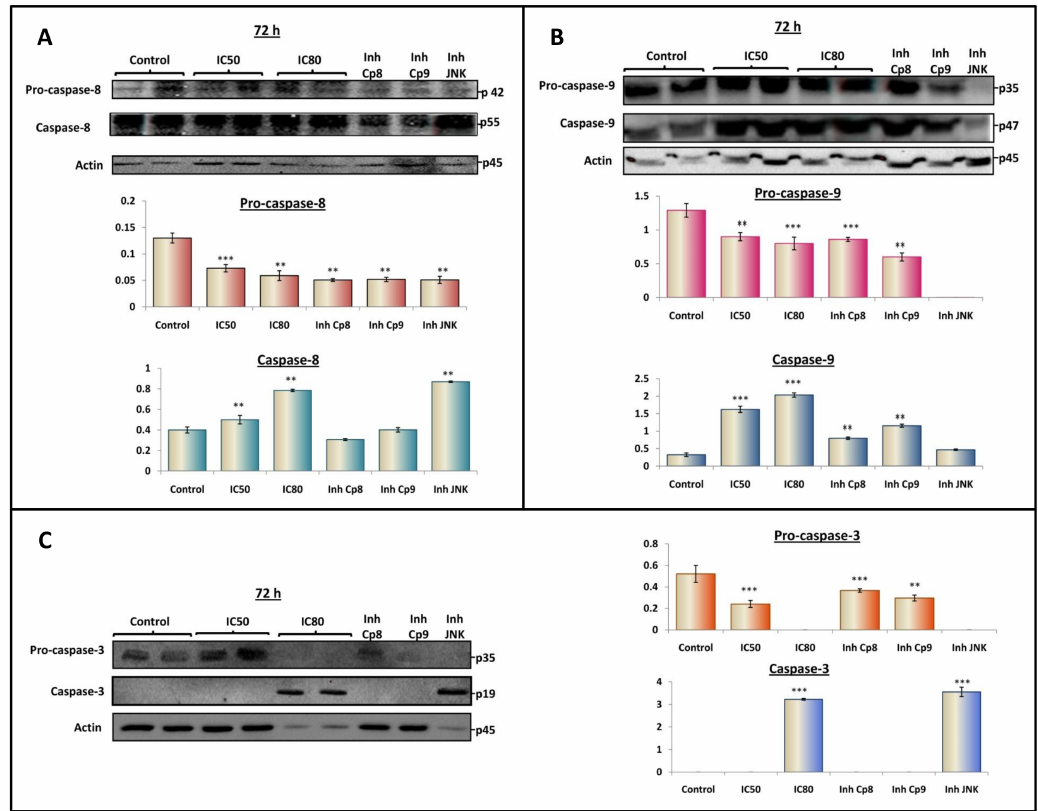
Figure 6. Western blotting analysis of the levels of pro-caspase-8, caspase-8 ( A );